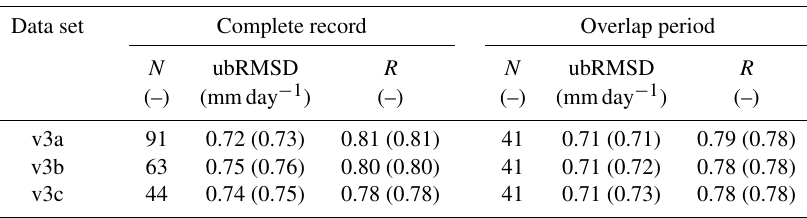
Figure 6. Impact of the data assimilation system in GLEAM v3 on the surface soil moisture for the CONUS. Left-hand side figures show the difference in anomaly correlations against in situ measurements for the GLEAM v3 surface soil moisture data sets with and without (open loop) the assimilation of satellite-derived soil moisture ( R an ( DA , in situ ) − R an ( OL , in situ ) ). Maps in the central panel show the difference in anomaly correlations against in situ measurements for the satellite-derived soil moisture data sets and the GLEAM v3 soil moisture data sets without data assimilation ( R an ( SAT , in situ ) − R an ( OL , in situ ) ). Maps on the right show the quality factor γ calculated in the data assimilation system. The latter balances both the model and observation errors, with values above (below) 0.5 indicating a lower (higher) error in the observations relative to GLEAM. Table 4. Average validation statistics for the different evaporation data sets (v3a, v3b, and v3c) against in situ measurements: ubRMSD is the unbiased root mean square difference, R is the correlation, and N is the number of sites included in the sample. The first part of the table reports the averaged statistics over all available sites and the entire study period, while the second part shows the same statistics for a common sample of sites, and an overlapping study period (2011–2015) for the three data sets. The same statistics for the data sets produced using GLEAM v2 are reported between brackets.